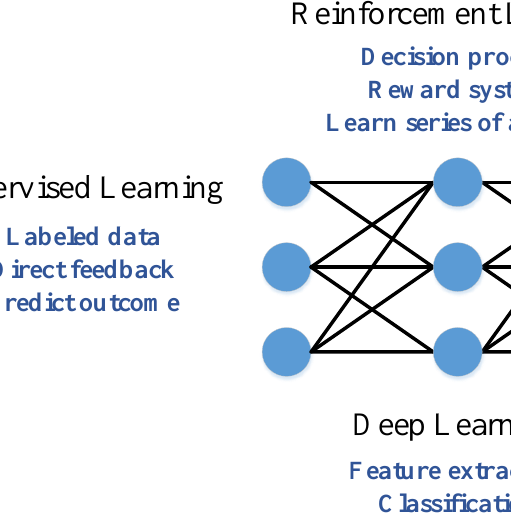
Figure 1. Various machine learning (ML) categories and their key